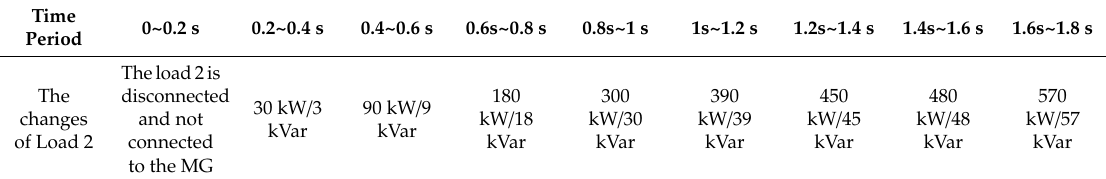
Table 7. The changes of load